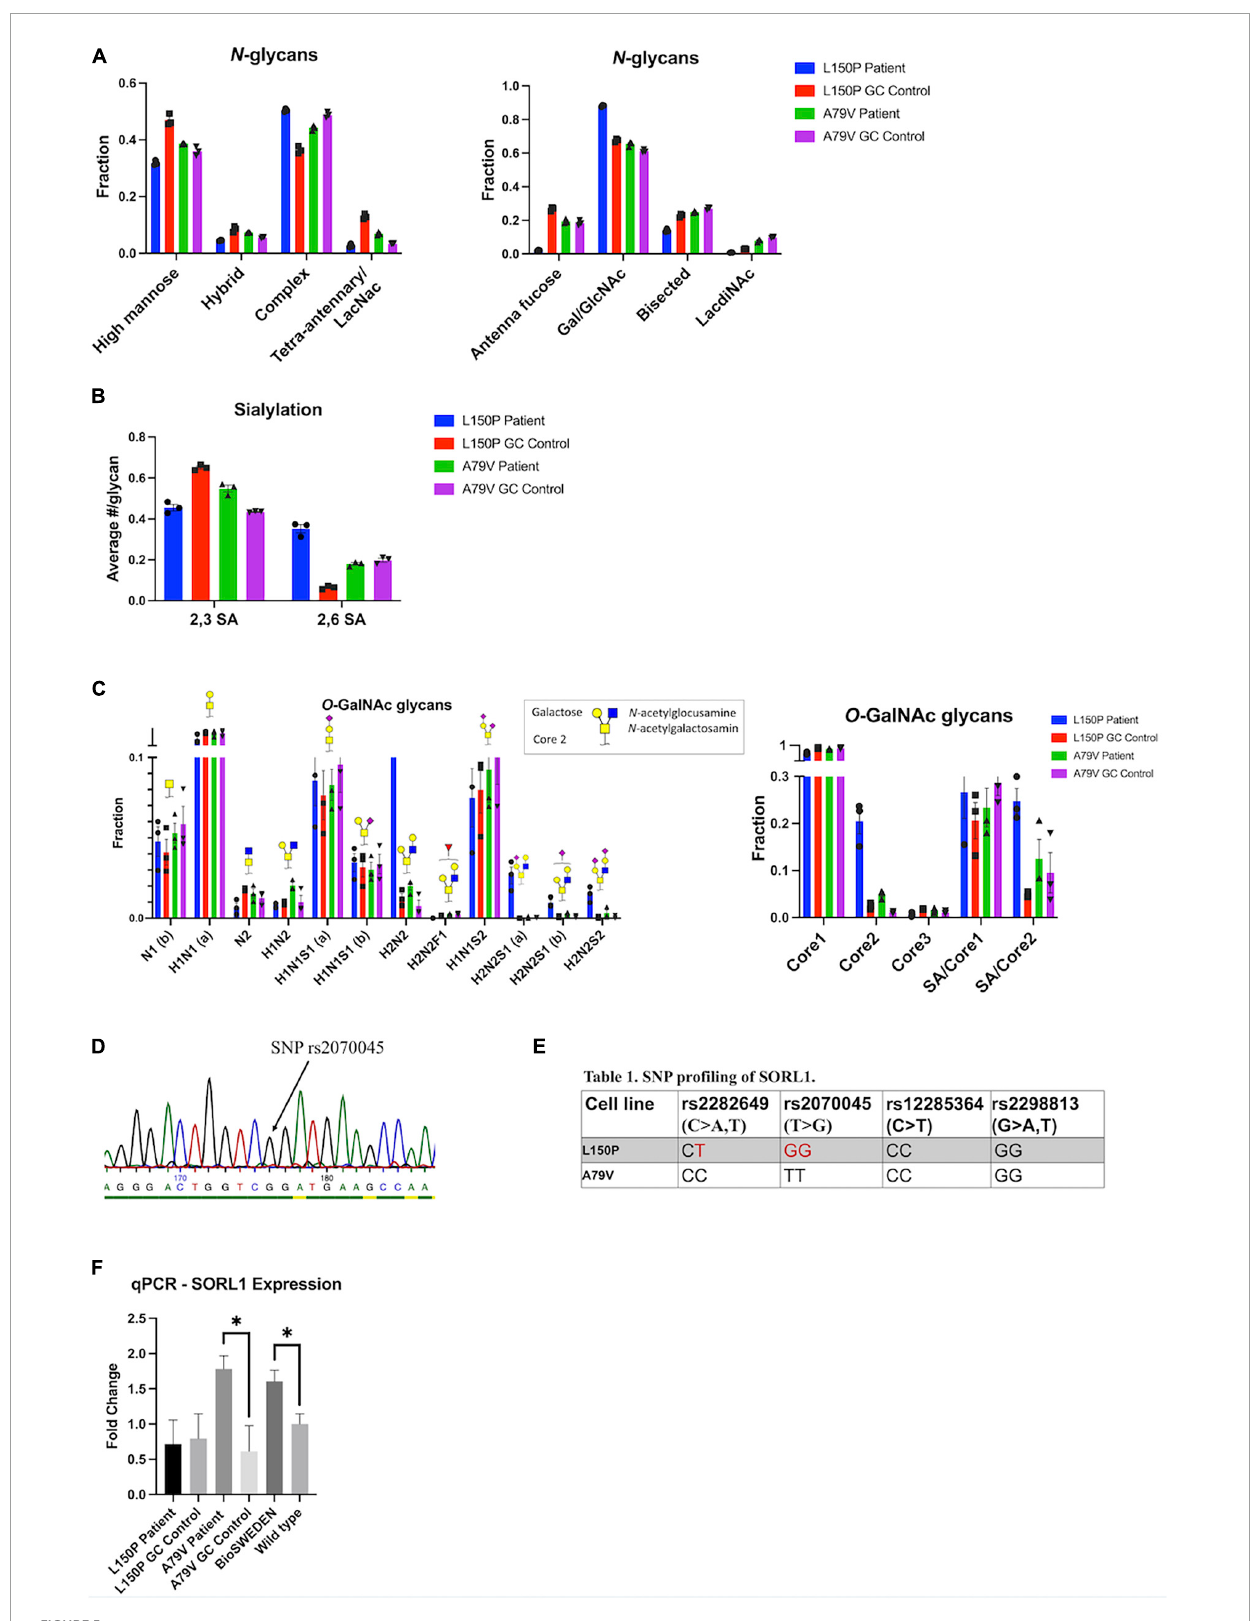
FIGURE5 Golgi fragmentation is not directly affecting Golgi function, which is likely linked to multiple mechanisms. (A) N -glycan profiling. (B) N- glycan sialylation pattern. (C) O -glycan profiling. (D) Example of SNP profiling via Sanger sequencing. (E) SNP profiling of the SORL1 gene. (F) qPCR validation of SORL1 expression. Results are displayed as mean ± standard error of the mean (SEM) from three replicates. Significance levels are indicated by ∗ p <